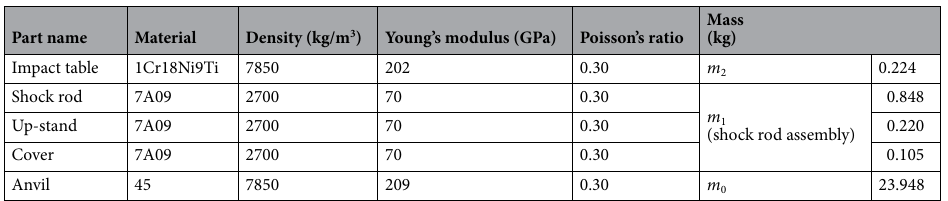
Table 1. Real design information for the three bodies.